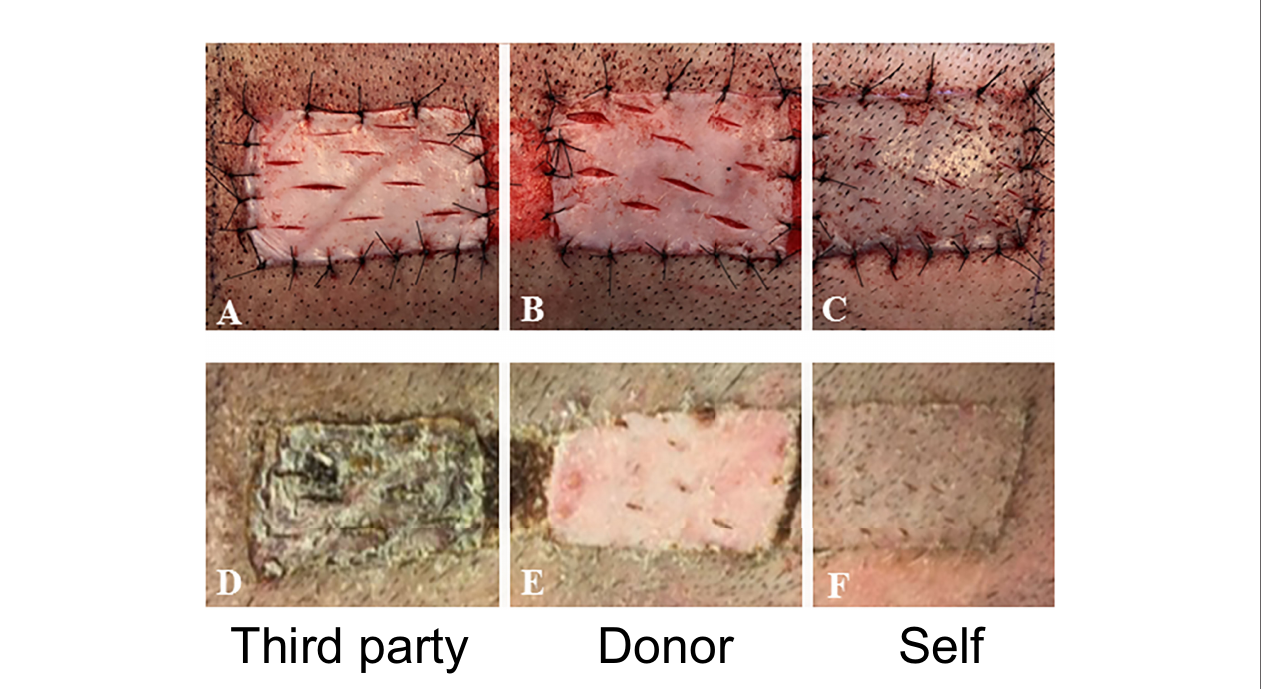
FIGURE 5 | In vivo test of immune competence by placement of split-thickness skin grafts from a third-party animal (A) , original donor (B) , and self (C) at POD 150 onto recipient swine tolerant of VCA (representative). By POD 14, there was complete rejection of the skin graft from the third-party animal (D) whereas that from the donor (E) and self (F) had